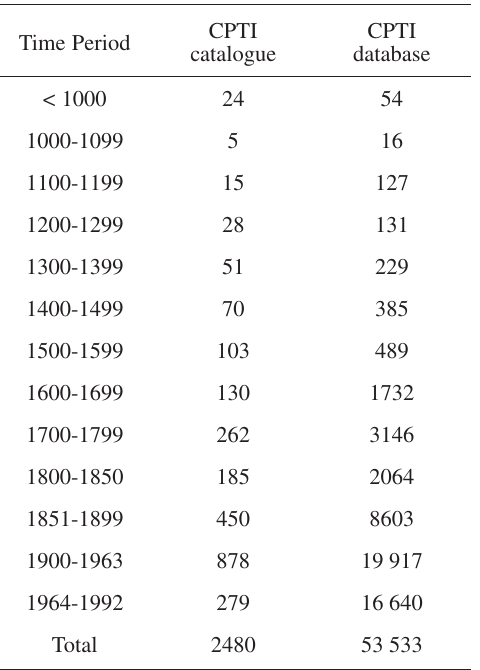
Table IV. Number of earthquakes in the CPTI cat- alogue (Working Group CPTI, 1999) and number of intensity data points in the corresponding Time Period